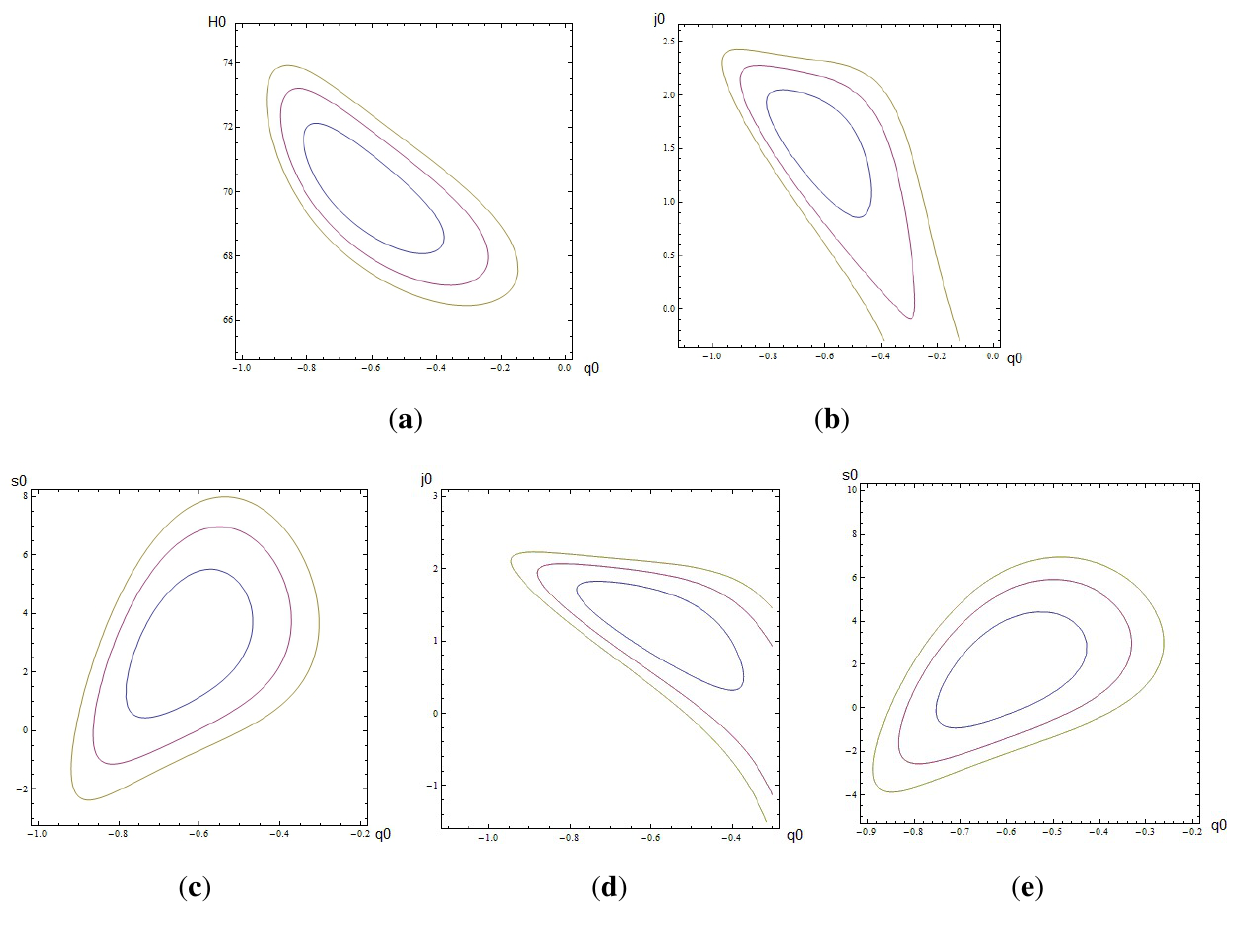
Figure 1. Two-dimensional marginalized contour plots for the set A and B by using the combined tests with SNeIa, BAO and CMB. We used the luminosity distance as a function of the redshift, z , only. The last two figures below are based on set B with h = 0 . 6996 . We showed in the plots the 1 σ , 2 σ and 3 σ confidence levels, evaluated by means of standard Bayesian analyses on a